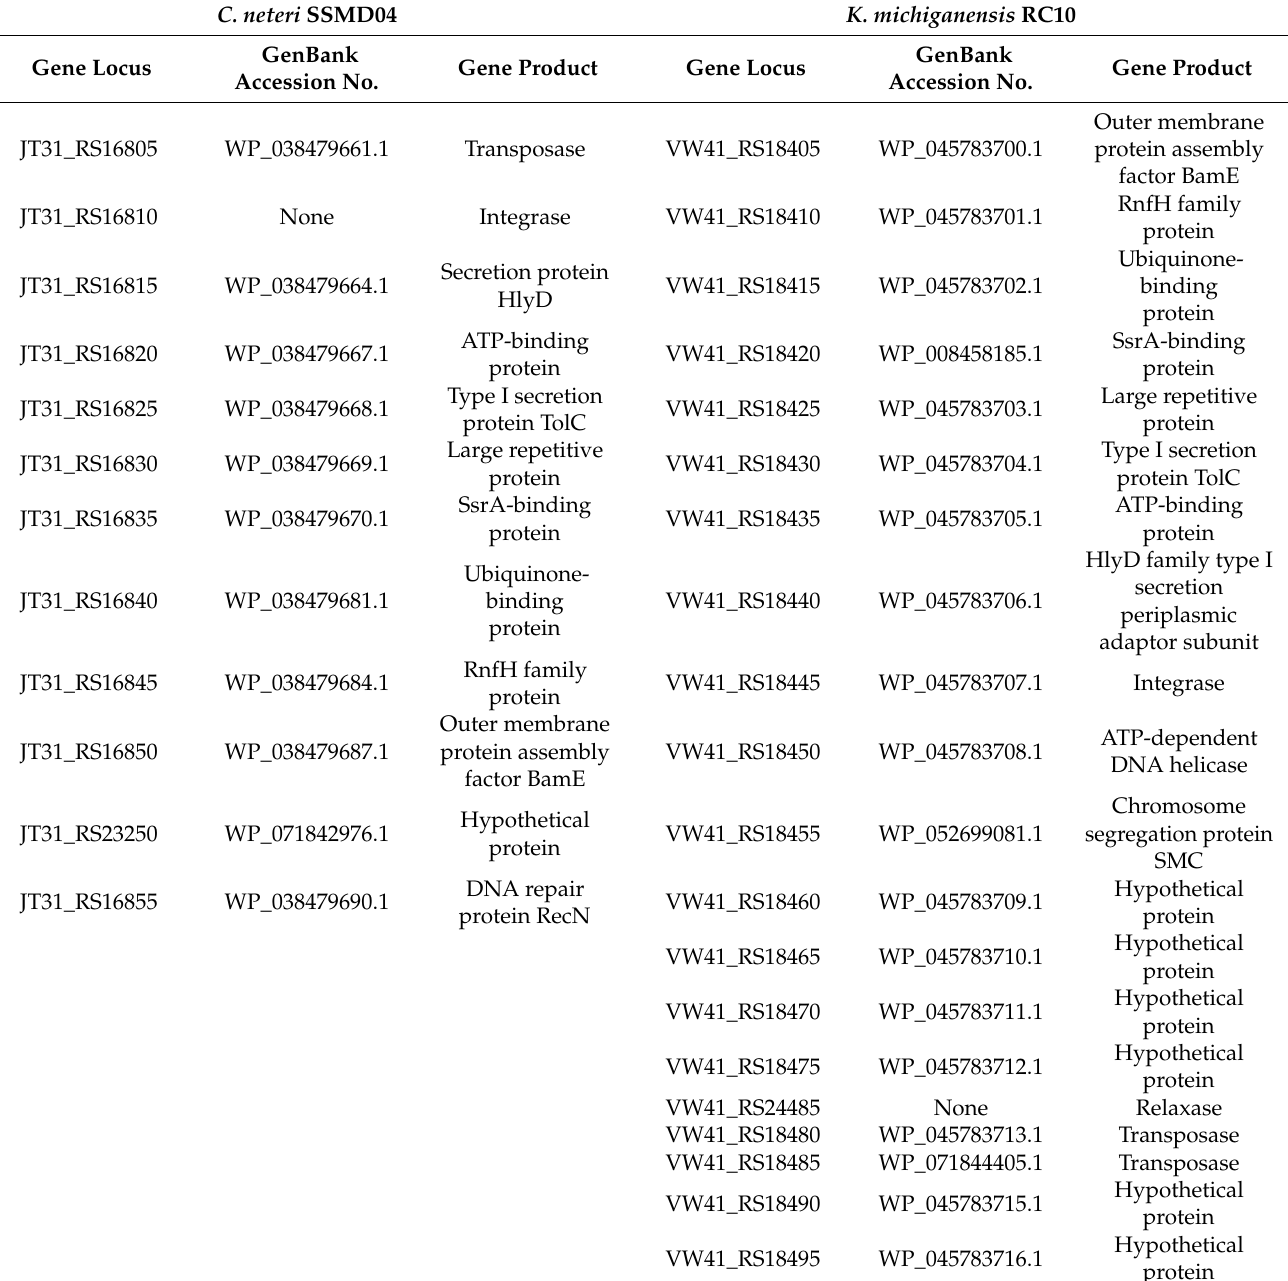
Table 3. Annotated genes in the predicted genomic island GI-1 of C. neteri and K. michiganensis